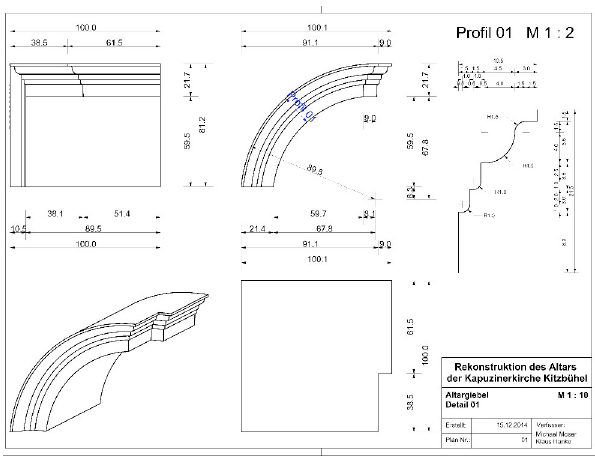
Figure 10: One of the final detail plans for the